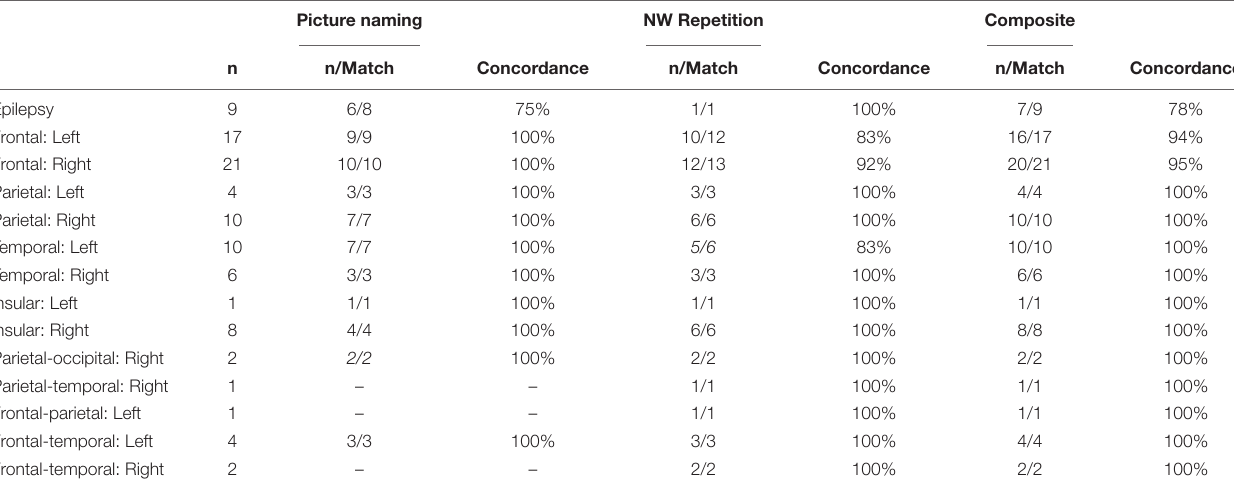
TABLE 1 | Results broken down my clinical case status (epilepsy, tumor location), sample size, and matching with laterality results from verb generation. Picture naming